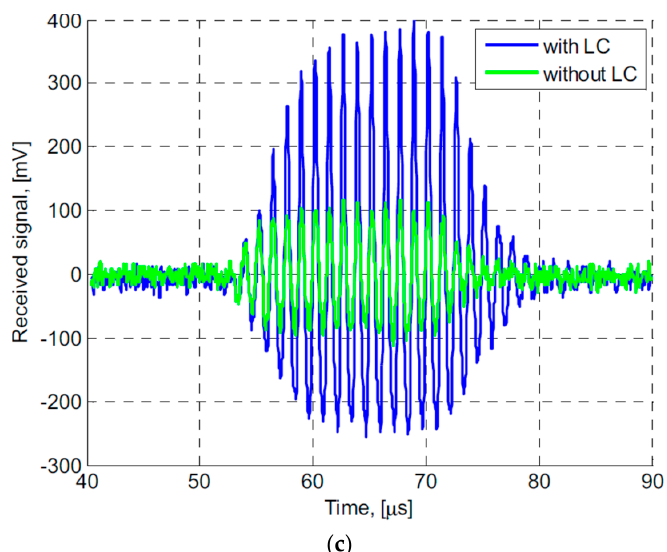
Figure 12. (a) Simulated impedance using PSPICE simulation software corresponding to an Figure 12. ( a ) Simulated impedance using PSPICE simulation software corresponding to an air-coupled air-coupled ultrasonic transducer. (b) Simulated power using PSPICE simulation software ultrasonic transducer. ( b ) Simulated power using PSPICE simulation software corresponding to an corresponding to an air-coupled ultrasonic transducer with and without the matching circuit air-coupled ultrasonic transducer with and without the matching circuit components. ( c ) Comparison components. (c) Comparison of experimental signals received by a hydrophone due to excitation of of experimental signals received by a hydrophone due to excitation of an air-coupled transducer at an air-coupled transducer at 800 kHz with and without electrical impedance matching circuit. 800 kHz with and without electrical impedance matching circuit. Reproduced from Reference